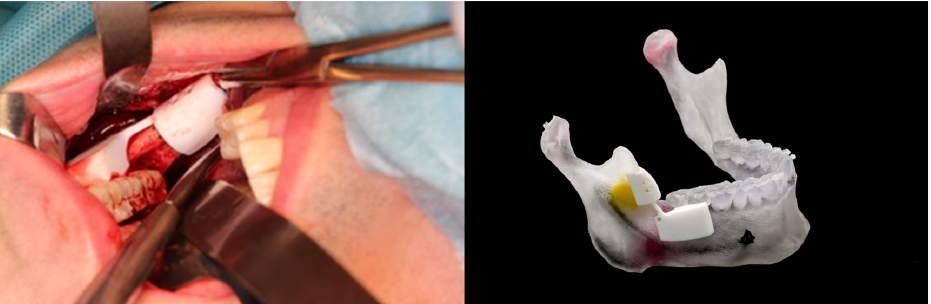
Figure 4. Anatomical model and cutting guides for surgical treatment of a complex benign neoplasm (Maxillofacial Surgery). Left: Surgical field and intraoperative vision with the surgical guide in place. Right: Surgical guide in polyamide material manufactured with SLS technology. Anatomical model of the jaw and neoplasms manufactured by MJ technology for planning the surgery based on DICOM images.